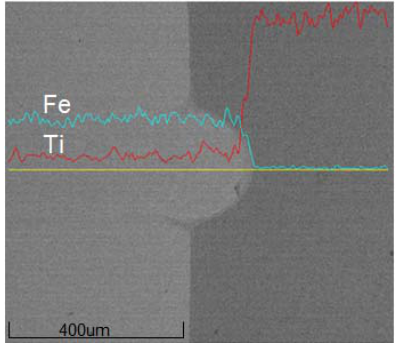
Figure 9. Distribution of elements Ti and Fe along the axis line of weld.